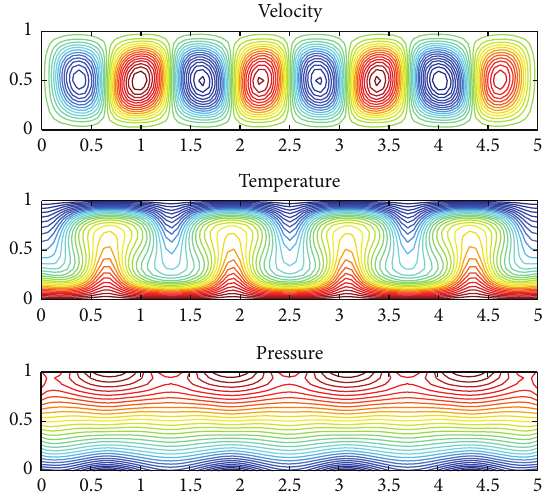
Figure 3: Example 20: streamlines of velocity and isolines of temperature and pressure, at time 𝑡 = 1.0 . The nondimensional parameters are 𝜅 = 10 4 ,𝜆 = 1 , and 𝜇 = 1 , and the discretization parameters are 𝜏 = 10 −3 ,ℎ = 2 −4 .